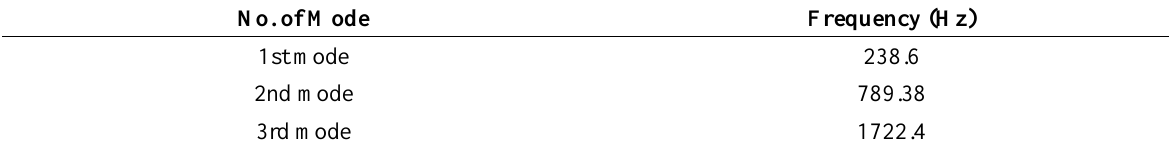
Table 3. Frequencies of cracked beam, subject to tensile load